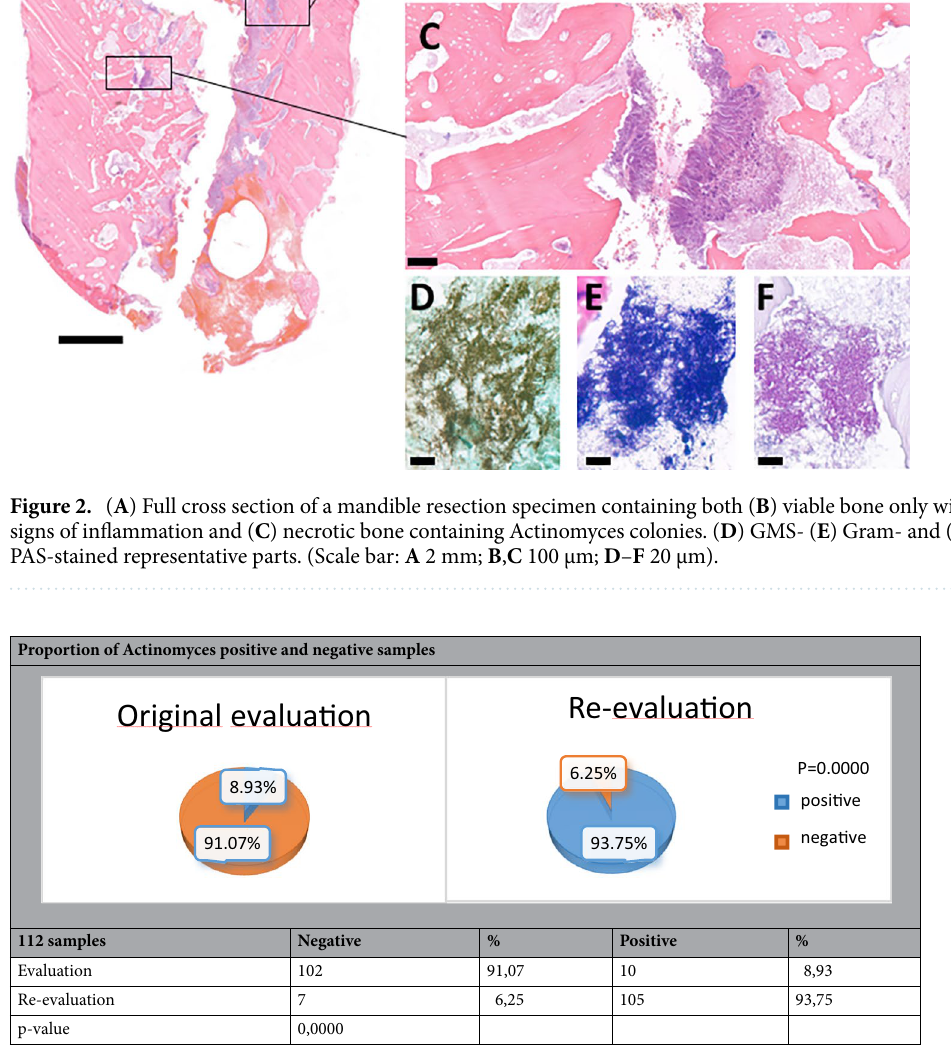
Table 1. Original evaluation was performed on HE-stained sections, while the re-evaluation was specifically focused on the presence of Actinomyces and complements with special stains. Actinomyces colonies could be detected in 105 (93.75%) of the re-evaluated cases, while it was described only in 10 (8.93%) samples in the original evaluation.